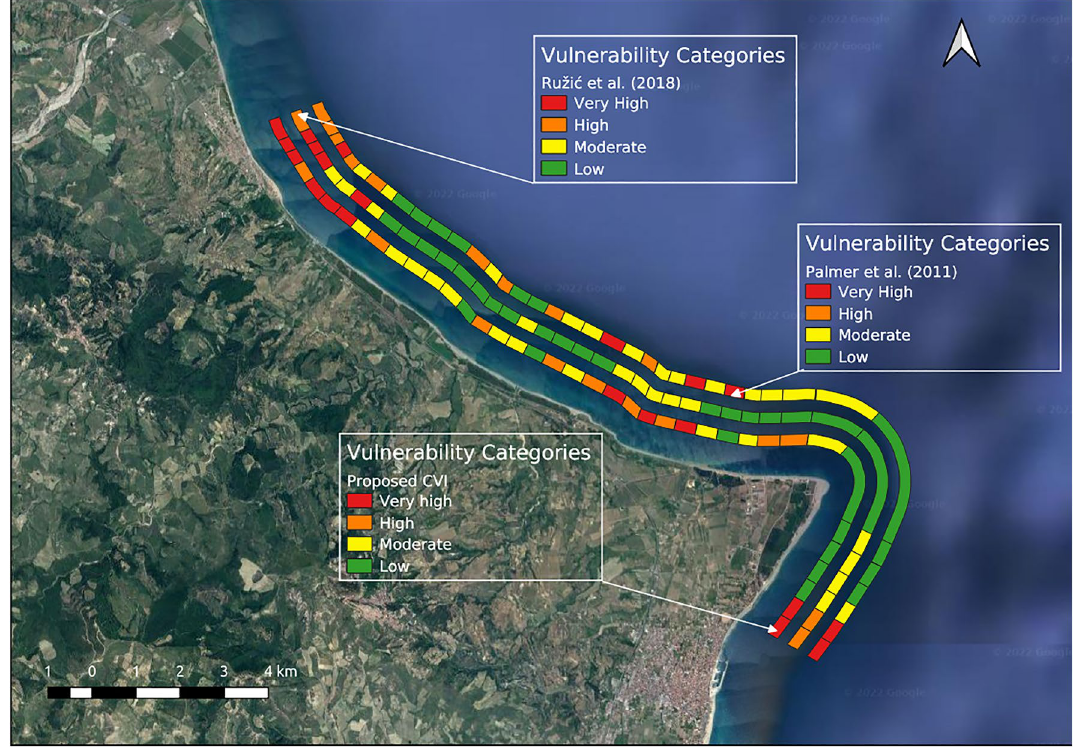
Figure 7. Proposed CVI formulation and CVI formulations proposed by Ružić et al. 46 and Palmer et al. 47 . The map was created using QGIS 3.29 software (https:// qgis.